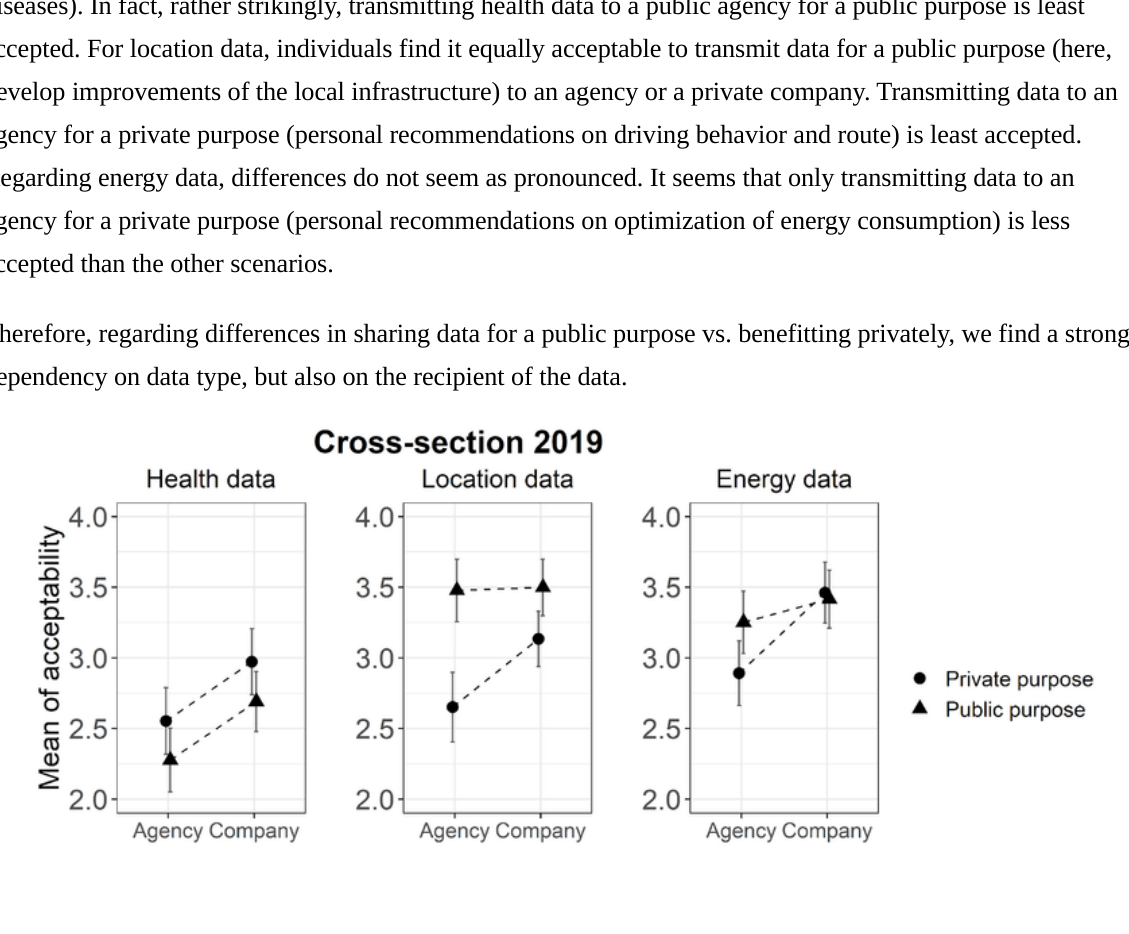
Figure 3. Mean acceptability of different data transmissions, depending on data type, data use, and recipient of the data. Vertical bars indicate 95% confidence intervals. N = = 1,401. Weighted